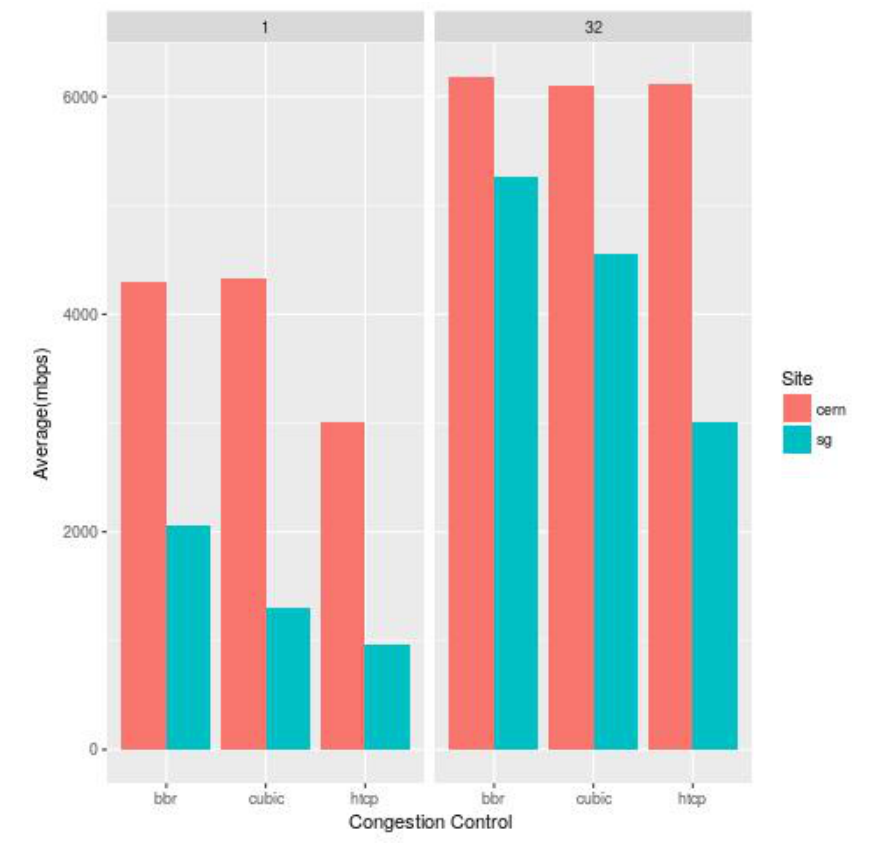
Figure 2. Brunel-ESnet upload and download iperf3 Figure 1. Brunel-Singaren upload and download iperf3 tests .